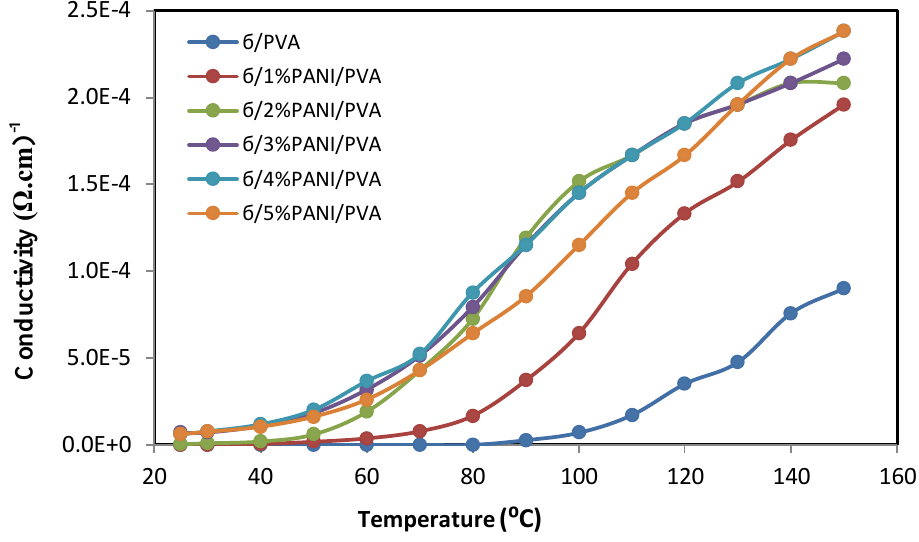
Figure 6: Ionic conductivity as a function of Temperature for PVA before and after PANI